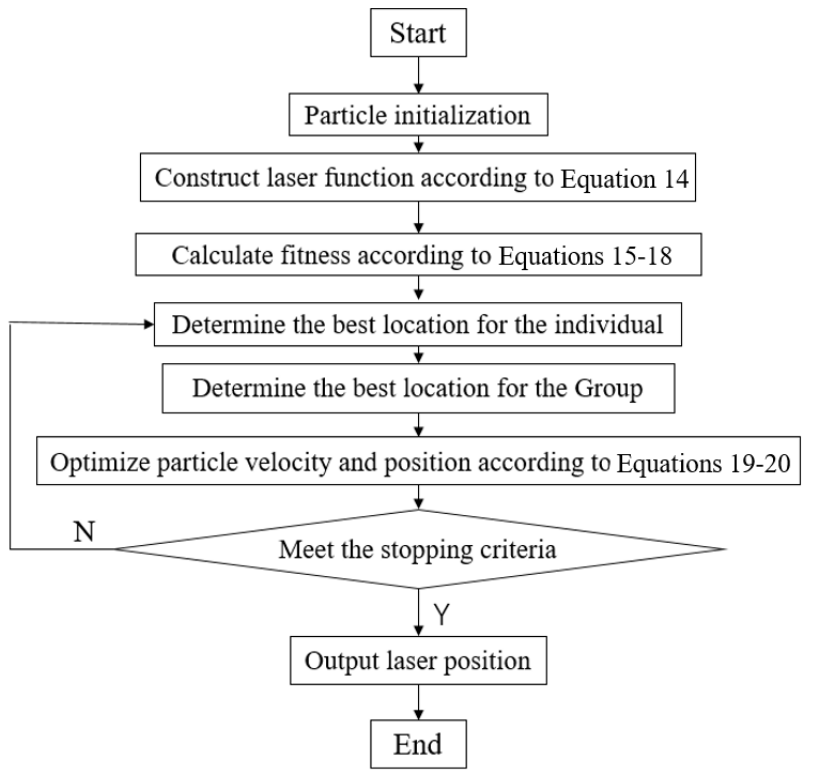
Figure 5. Flow chart particle swarm algorithm that details the process of using the particle swarm algorithm to find the position of the laser. The same process is true for the LED.